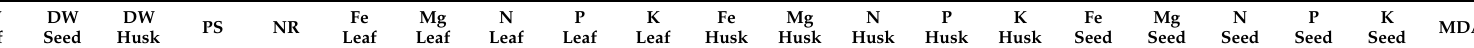
Table 3. Pearson’s coefficient of correlation between parameters with corresponding r